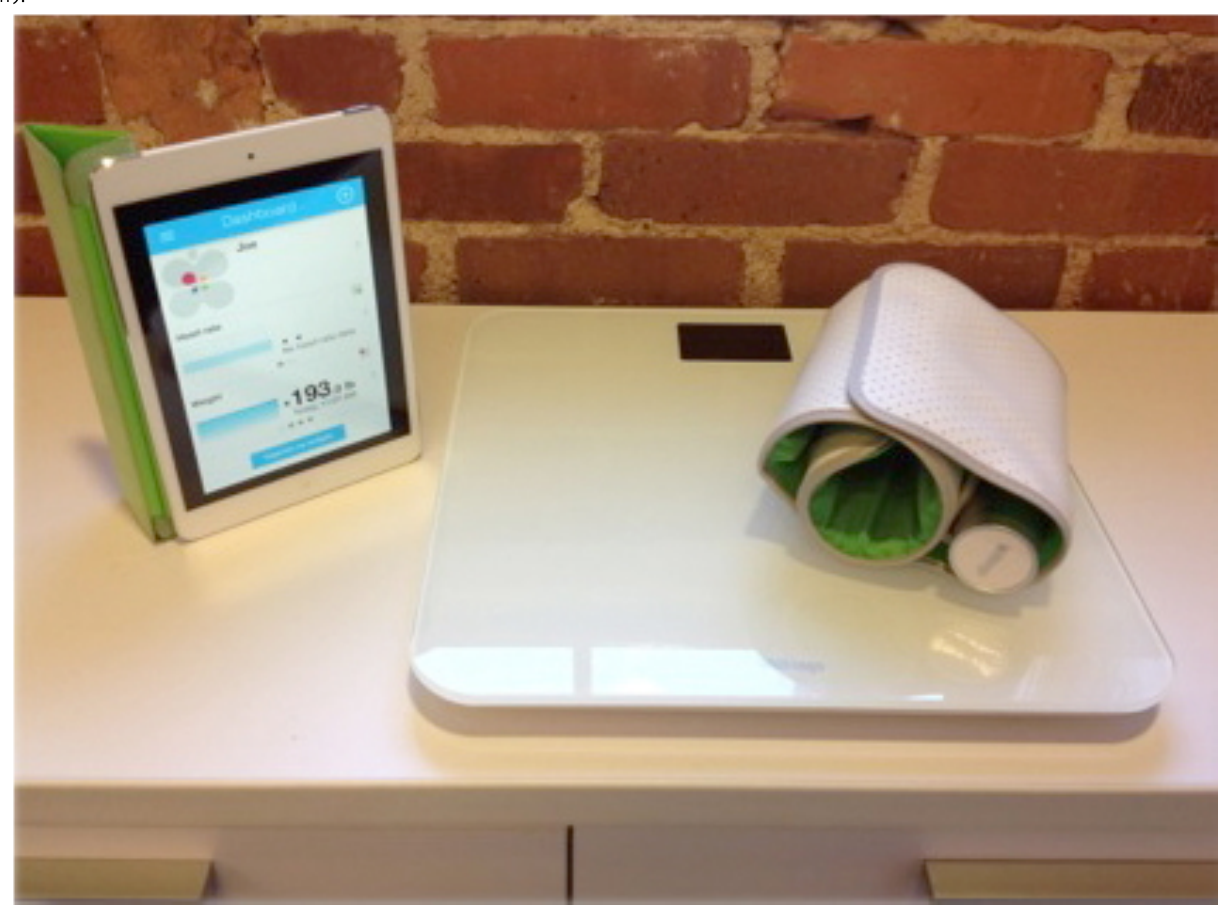
Figure 1. Portable devices provided to participants as part of the intervention (from left: iPad Mini, bluetooth weight scale, auto-inflating blood pressure